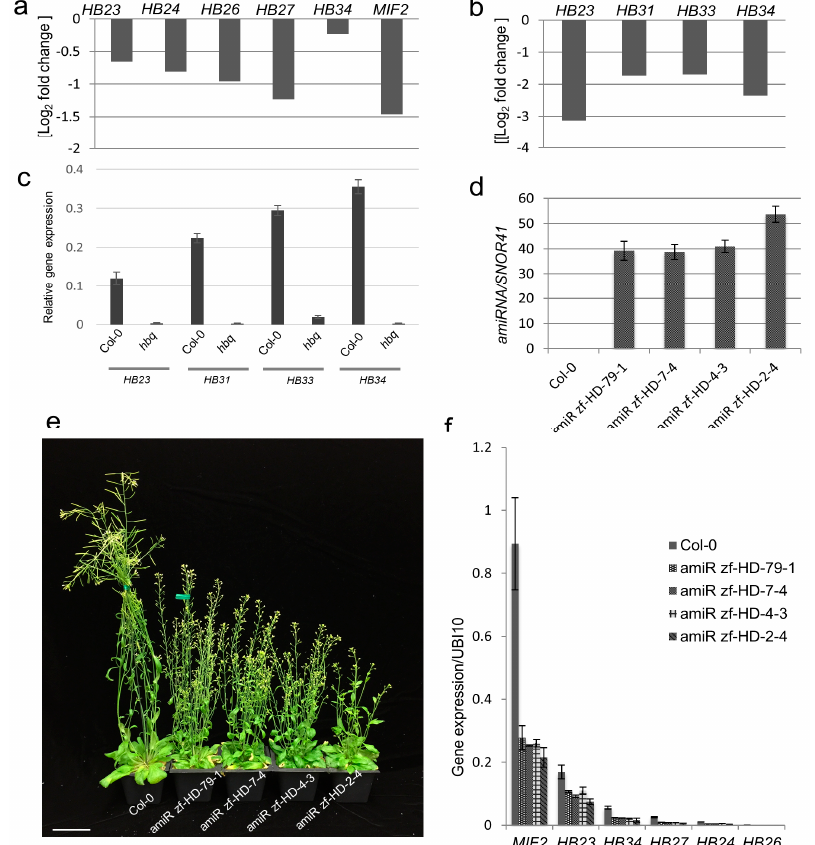
Figure 2. Phenotypes of zf - hd mutants are the result of disturbed expression of ZF-HD TF genes. Expression of ZF-HD TFs in amiR zf-HD ( a ) and hbq ( b ), as determined by RNA-seq, in comparison with WT ( p value < 0.05). ( a , b ) Three biological replicates were used for RNA-seq and figures shown as average of expression value (Log2 fold change). p value refers to the cutoff for determining whether the genes were significantly differentially expressed in the mutant relative to WT. It is determined by the differential expression analysis software based on the expression levels observed across replicates. ( c ) Expression of HB23 , HB31 , HB33 , and HB34 was monitored by qRT-PCR in Col-0 and hbq . ( d ) Expression of amiRNA in young floral tissue in four independent homozygous transgenic lines: amiR zf-HD − 79 − 1, amiR zf-HD − 7 − 4, amiR zf-HD − 4 − 3, and amiR zf-HD − 2 − 4. ( e ) Phenotype of mature Col-0 plant and four individual amiR zf-HD transgenic lines. Scale bar: 5 cm. ( f ) Target expression of amiRNA in four individual amiR zf-HD transgenic homozygous lines (amiR zf − HD − 79 − 1, amiR zf − HD − 7 − 4, amiR zf − HD − 4 − 3, and amiR zf − HD − 2 − 4) relative to WT.